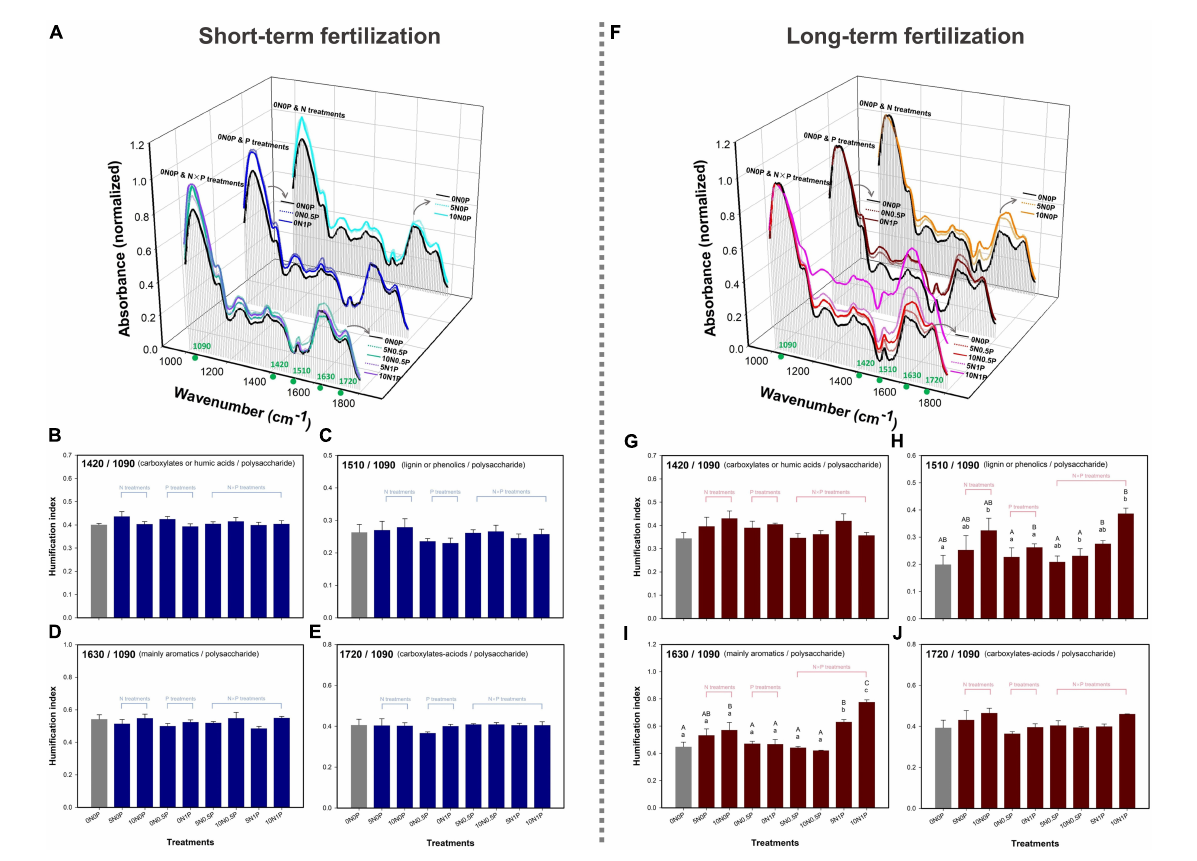
FIGURE3 Fourier-transform infrared (FTIR) spectra under the short- (A) and long-term fertilizations (F ), and the humification indices under the short- (B–E) and long-term fertilizations (G–J) . Different lowercase letters represent significant differences among N treatments under the same P addition rate in the long-term fertilization. Different uppercase letters represent significant differences among P treatments under the same N addition rate in the long-term